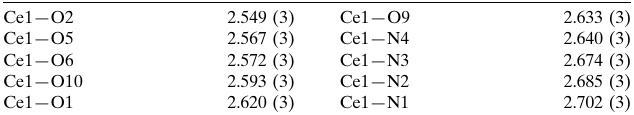
Selected bond lengths (A˚ ).